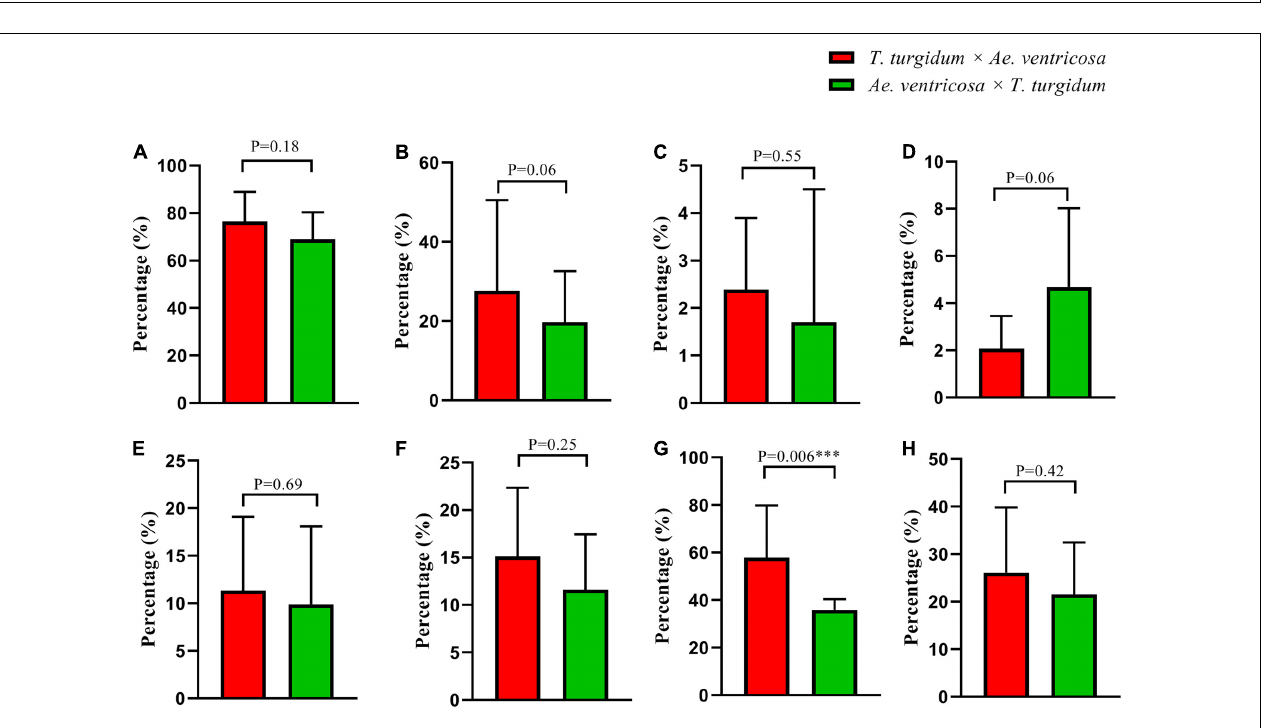
FIGURE 9 | The distribution of chromosomal structural variations of four subgenome (A) , and the FISH karyotype of chromosomal structural changes (B) by use of chromosomal structural variations. ∗ 1, 3BL.3BL; ∗ 2, 5N v L.5N v L; ∗ 3, 7AS.7D v L; ∗ 4, 7N v L.3BL; ∗ 5, 5AL.5AL; ∗ 6, 7D v S.7AL. Circles denote chromosomes with breakages occurring in non-centromeric region.